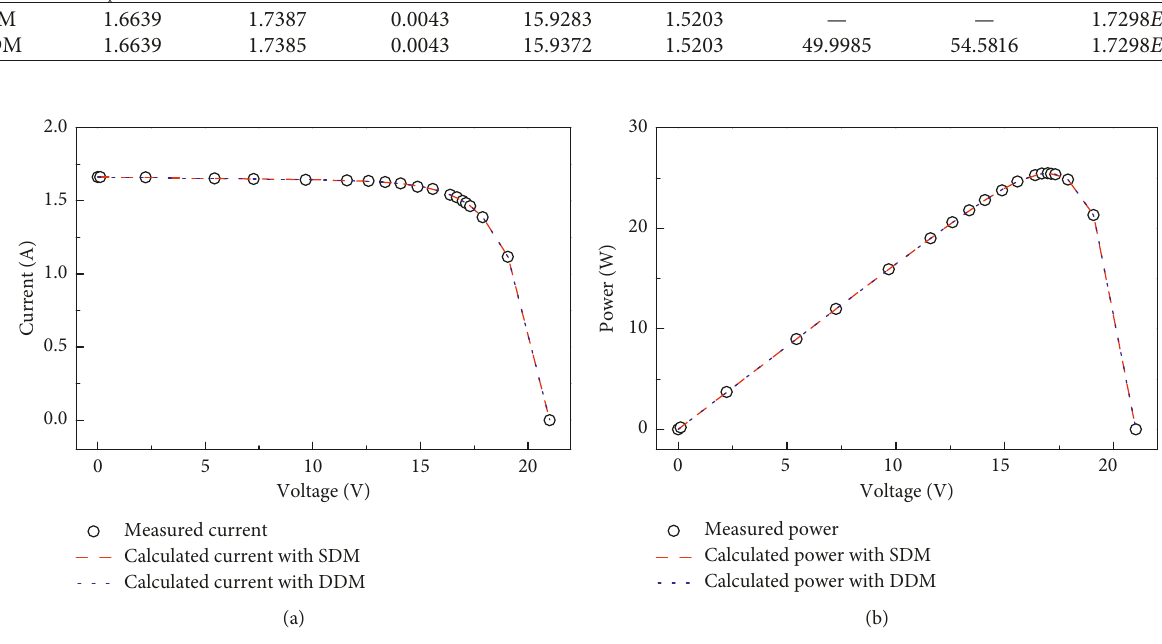
Figure 10: Comparison between the measured and calculated data achieved by SDO for the STM6-40/36 monocrystalline module. (a) I-V characteristic; (b) P-V characteristic. Table 11: Calculated results for the STM6-40/36 module by